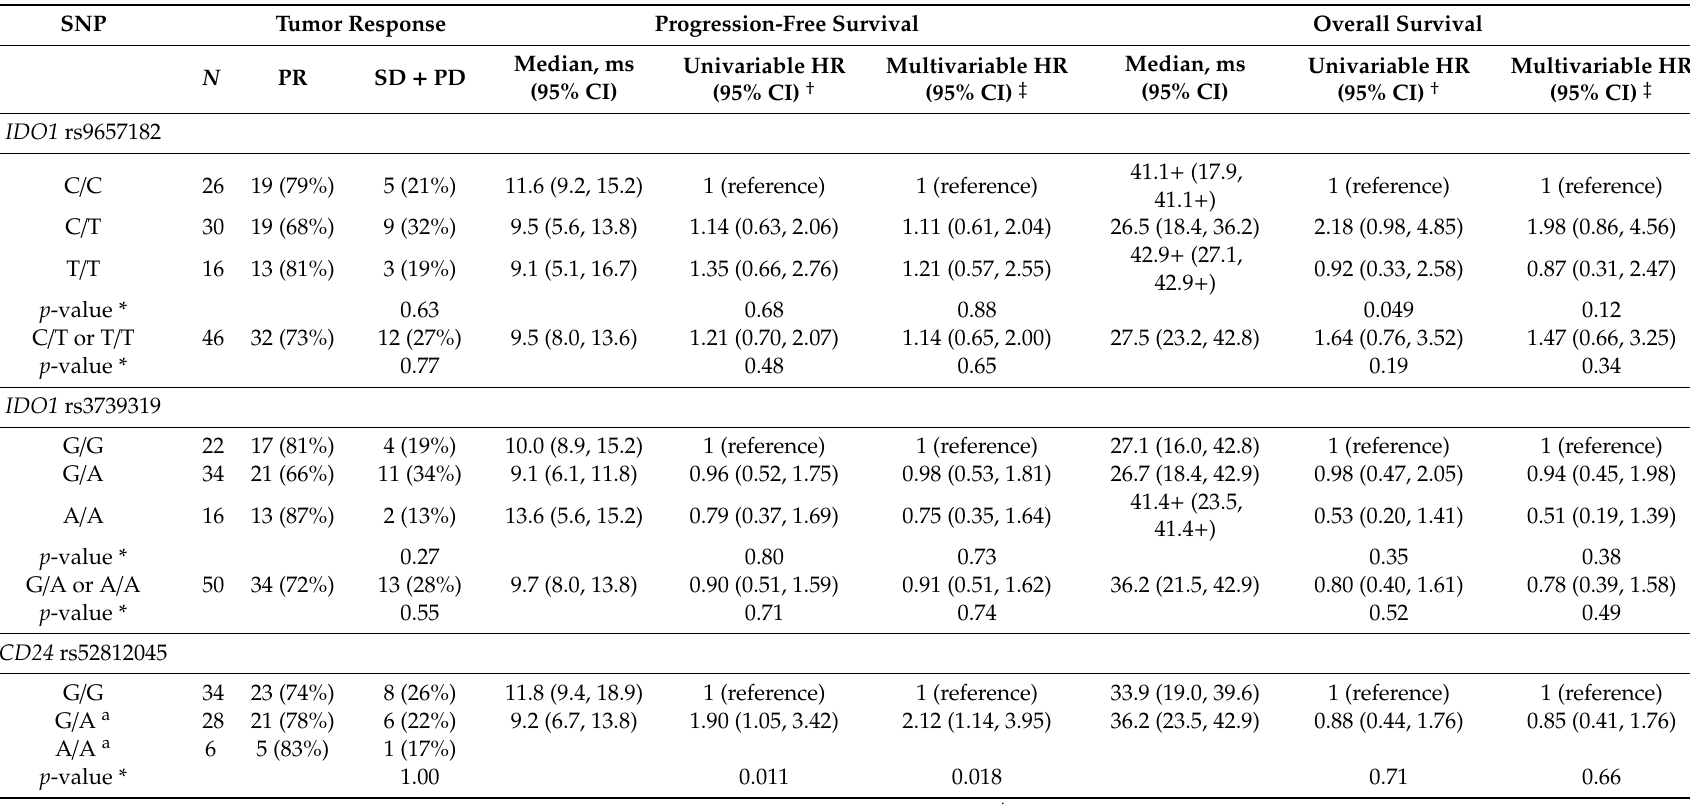
Table 4. Immune regulatory SNPs and outcomes in Japanese patients receiving first-line cetuximab plus oxaliplatin-based therapy (validation cohort 2). SNP Tumor